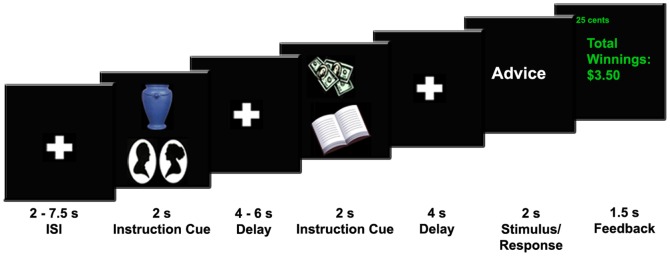
Trial Structure for the fMRI Experiment.After a variable duration fixation cross, an instruction cue signaled the currently relevant rules (profile of faces = male/female rule; book = abstract/concrete rule) and whether or not to expect a monetary reward (blue vase = no money; bills = 25¢). This was followed by a variable duration delay period and then a word or face stimulus, during which subjects made a button response. Finally, a screen revealed whether money had been earned on that trial and cumulative winnings. On key trials, a second instruction cue appeared before the stimulus. Across the two instruction cues, we varied whether there was repetition of the rules, expected reward, both, or neither.